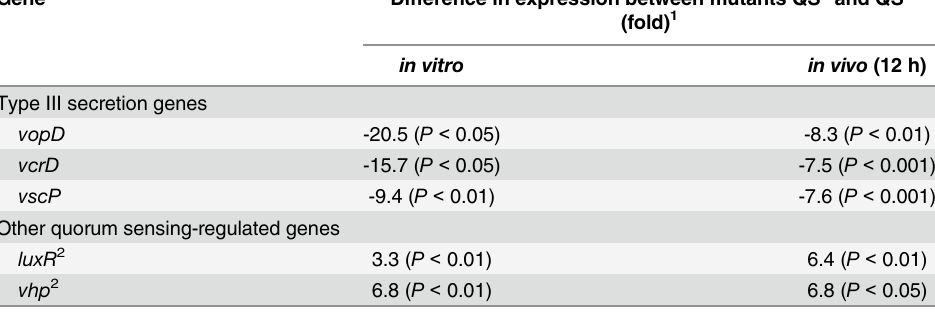
Table 1. Difference in expression of the type III secretion system genes vopD , vcrD and vscP , the quo- rum sensing master regulator gene luxR and the Vibrio harveyi metalloprotease gene vhp between a luxO mutant with the quorum sensing system locked in high cell density configuration (QS c ) and a luxO mutant with the quorum sensing system locked in low cell density configuration (QS - ), in vitro (in Marine Broth) and in vivo (in association with gnotobiotic brine shrimp larvae). The RNA polymerase A subunit ( rpoA ) mRNA was used to normalise between strains. Gene Difference in expression between mutants QS c and QS